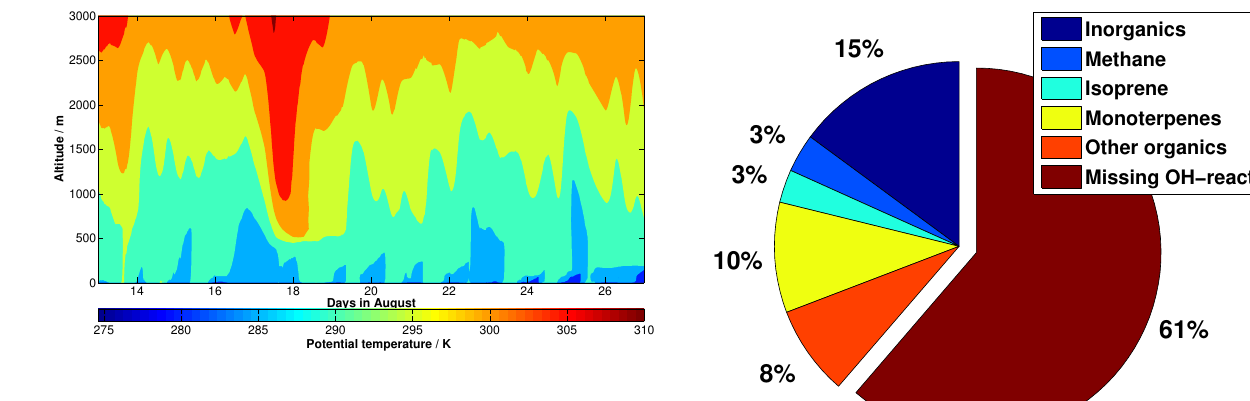
Fig. 2. Boundary layer heights expressed by potential temperature. Fig. 3. Calculated contributions to the OH-reactivity from the 13 to 27 August 2008.